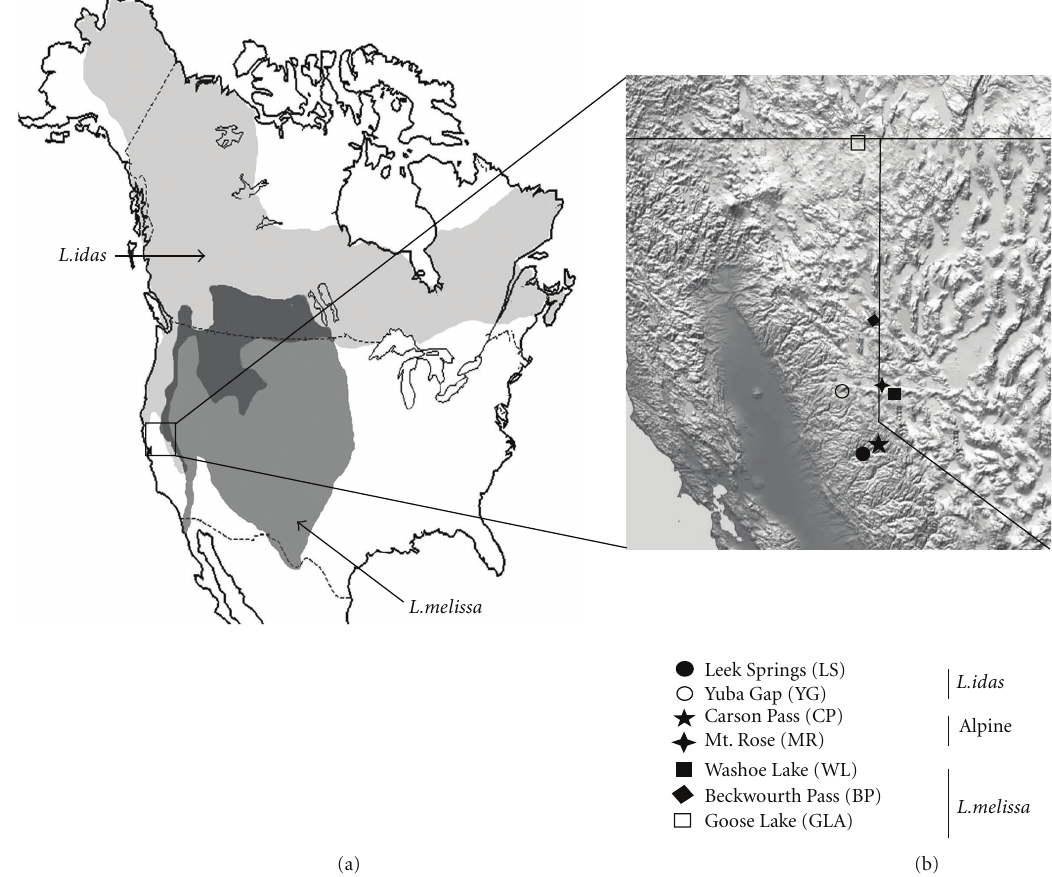
Figure 1: (a) Ranges of L. idas and L. melissa across North America, darker shaded regions correspond to ranges of overlap, which includes alpine populations of the hybrid species considered here (CP and MR). (b) Map of sampled Lycaeides populations in Northern California and Nevada, USA. Symbols correspond to populations and taxa.